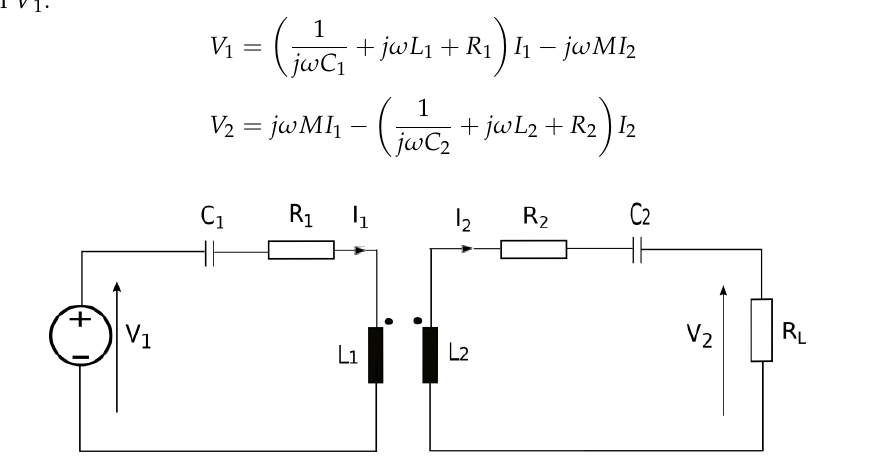
Figure 2. The bidirectional wireless system model for SS topology.